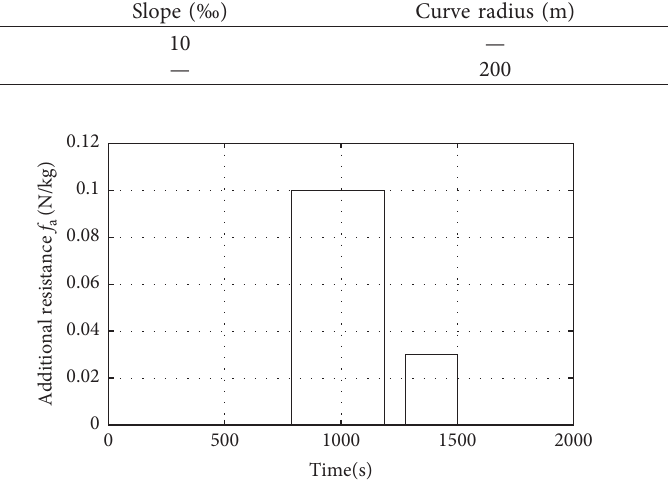
Figure 3: Diagram of additional resistance.